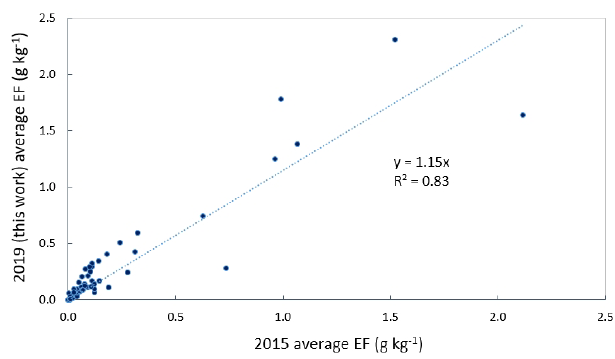
Figure 4. The 2019 study-average NMOG EFs (this work, four provinces including Central Kalimantan) versus the 2015 study- average NMOG EFs measured by Stockwell et al. (2016a) in Cen- tral Kalimantan for the 57 species measured in both studies.